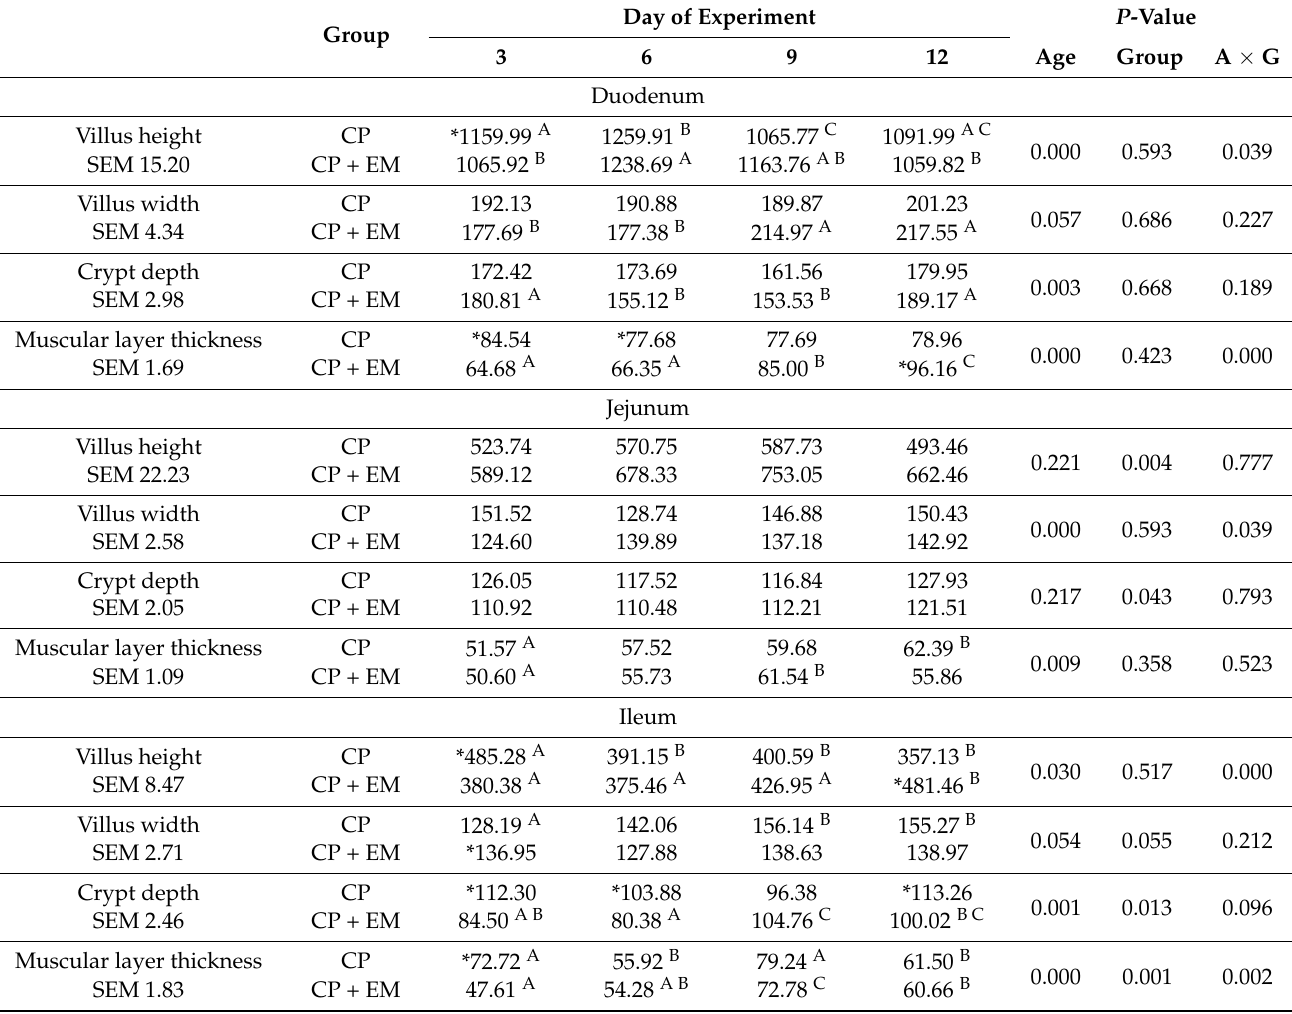
Table 4. Morphometrical analysis of the alimentary system on different days of the